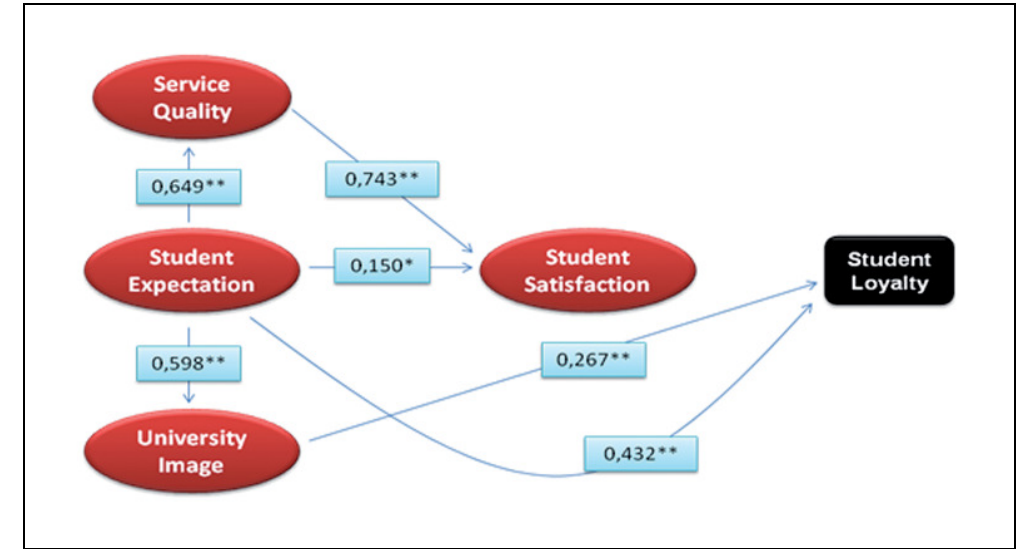
Figure 3 The results subsequent to